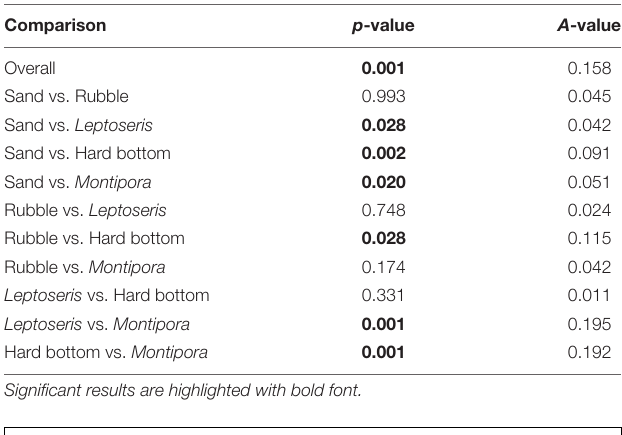
TABLE 4 | MRPP results of benthic habitat comparison.